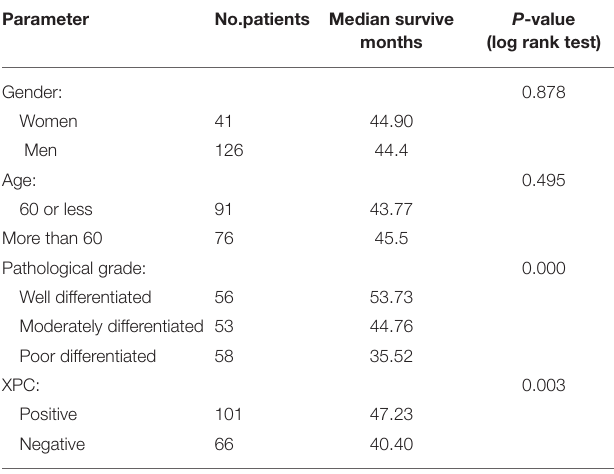
TABLE 2 | Univariate analysis of the influence of clinical characteristic on survival time in 167 patients with colorectal cancer. Parameter